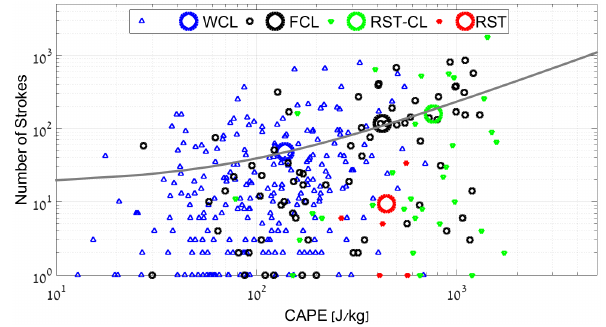
Figure 3. Number of strokes as a function of CAPE according to the four synoptic systems. The CAPE is taken from the GDAS data set. Both variables are estimated for the area between 32–33 ◦ N and 34–35 ◦ E. The CAPE is estimated at 00:00, 06:00, 12:00 and 18:00UTC, and the number of strokes is estimated for a time win- dow of ± 2h around these times. Centroids for the four subsets are marked by circles. A linear fit for WCL and FCL and RST-CL is shown in